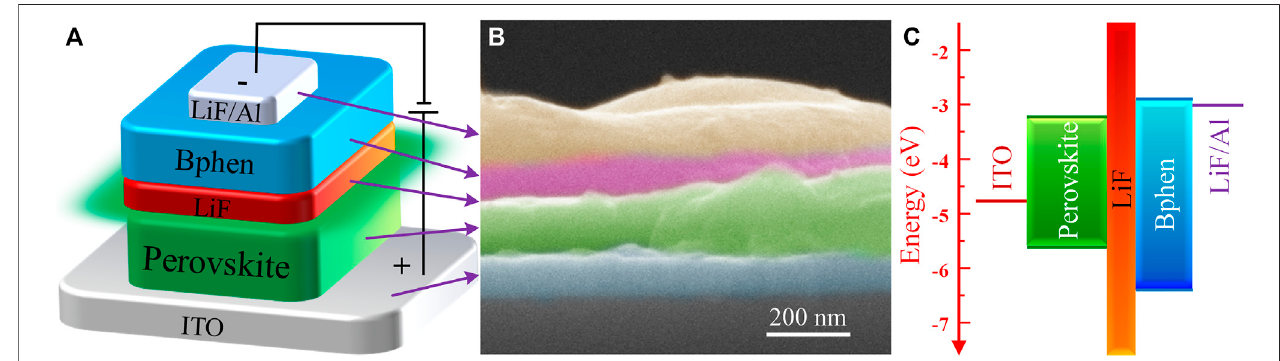
FIGURE 4 | (A) Device con fi guration and (B) cross sectional SEM image of the PeLED based on the all-inorganic perovskite fi lm with the molar ratio of PbBr 2 to CsBr = 1:1.5. (C) Energy band diagram of the perovskites and PeLED devices.